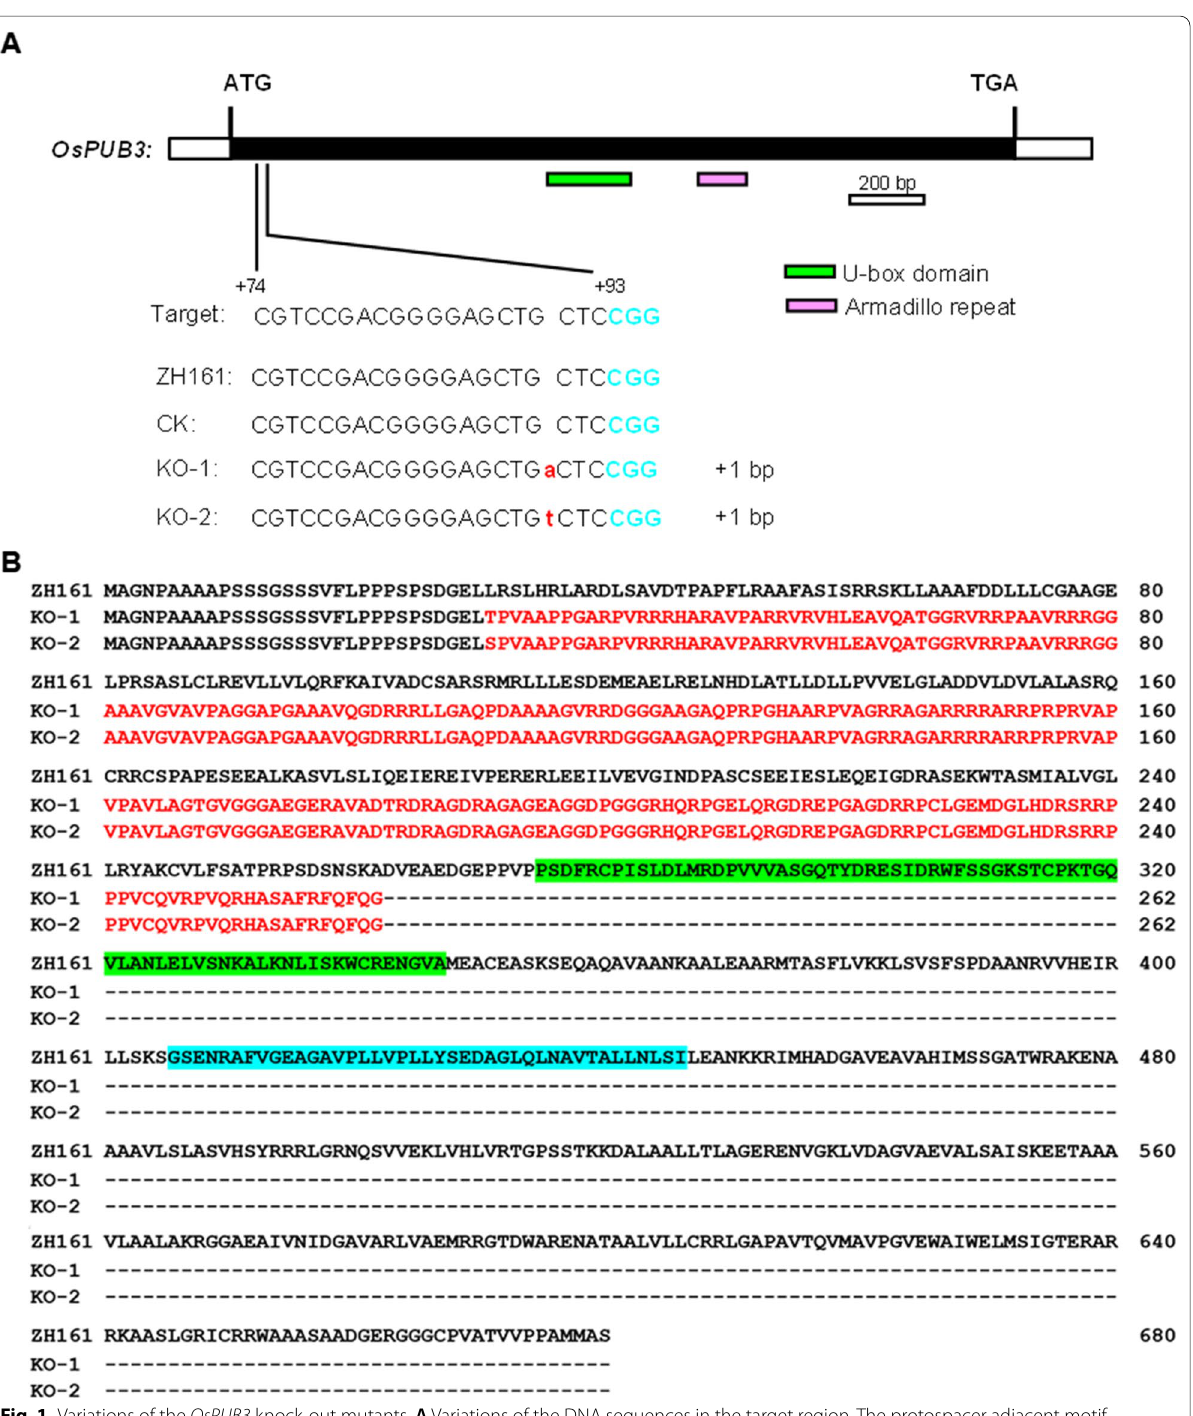
Fig. 1 Variations of the OsPUB3 knock‑out mutants. A Variations of the DNA sequences in the target region. The protospacer adjacent motif site is shown in blue. Insertion is indicated by lowercase letter in red. B Variations of the predicted amino acid sequences. Letters in red indicate amino acid sequences of frameshift mutation. U‑box domain is in green. Armadillo repeat domain is in blue. ZH161 is the recipient. CK is the transgenic‑negative control. KO‑1 and KO‑2 are two homozygous knock‑out